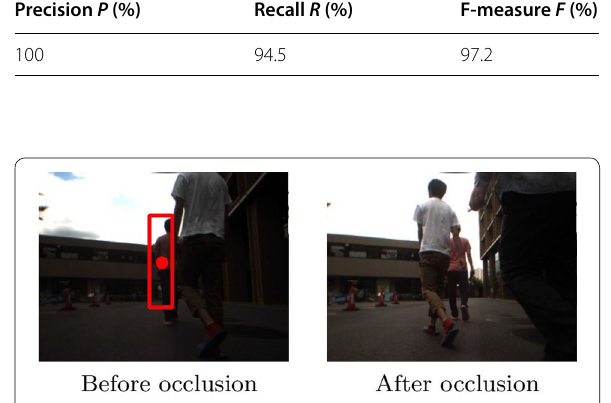
Fig. 12 Brightness changes during occlusion